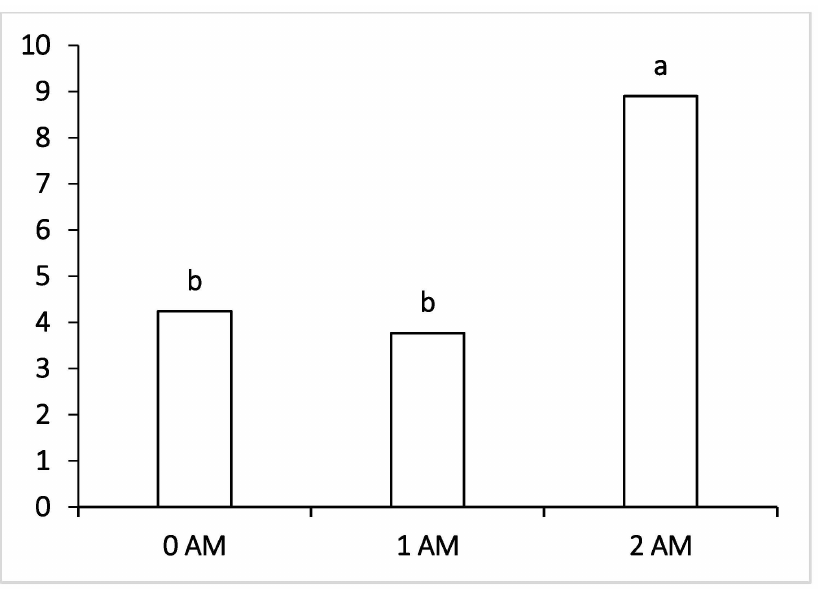
Figure 4. Effect of Agro-Matic supplementation on the rumen undesirable microflora